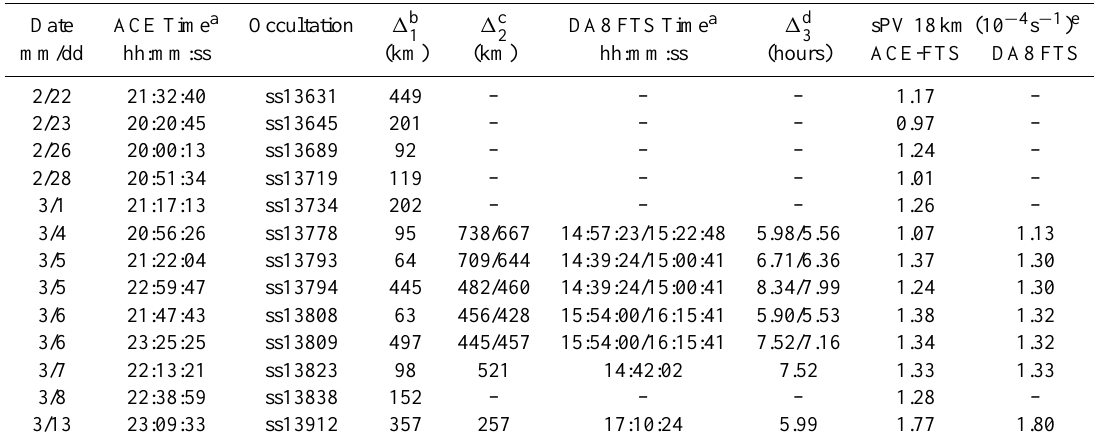
Table 7. The spatial and temporal differences between DA8 and ACE-FTS observations for O 3 , HNO 3 , and ClONO 2 during the 2006 Canadian Arctic ACE Validation Campaign.